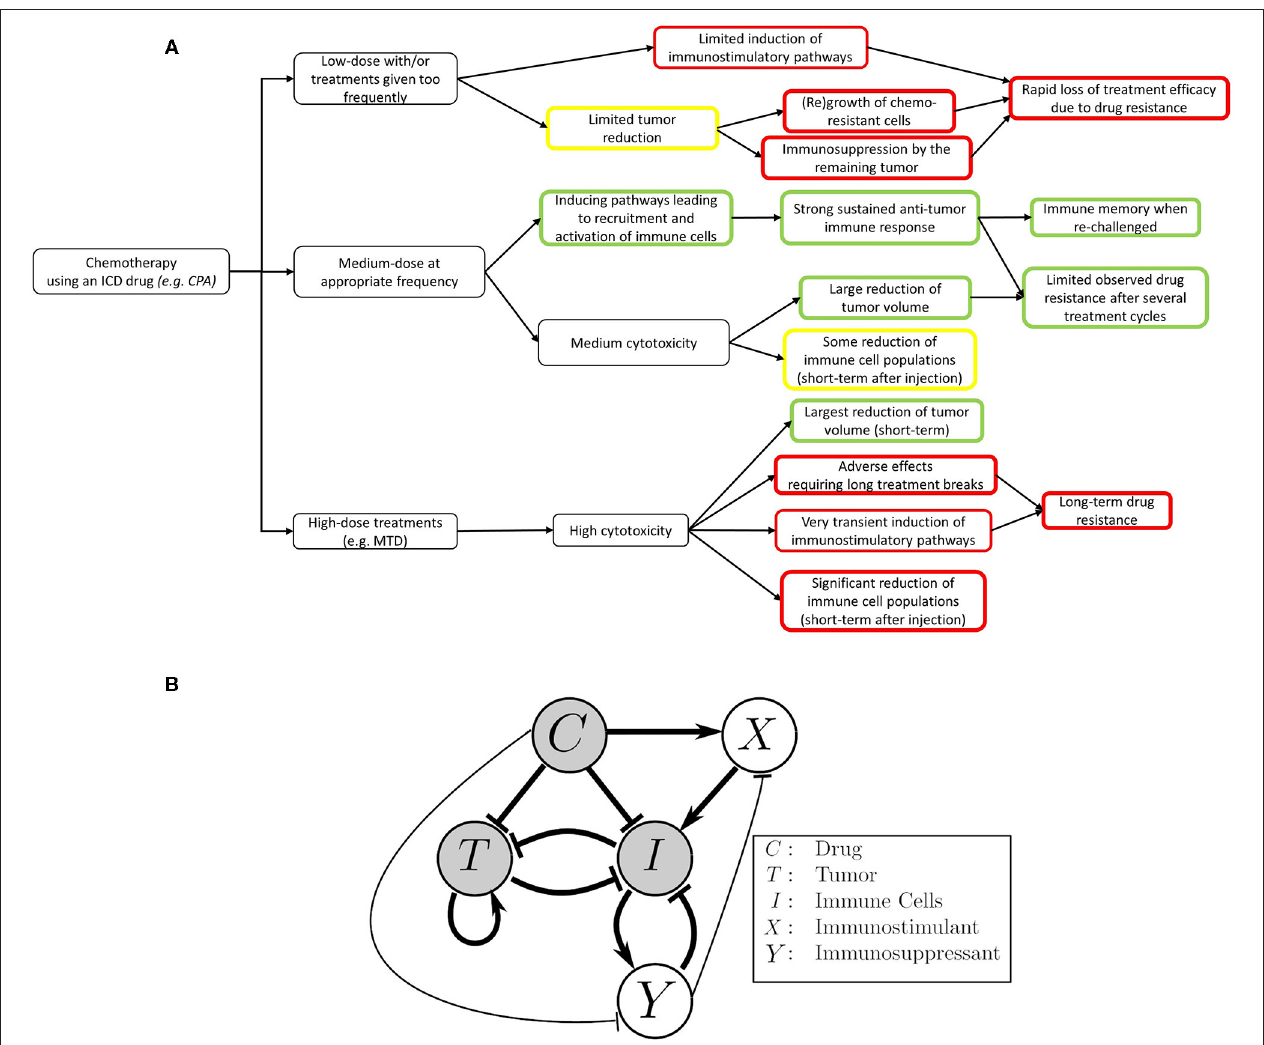
FIGURE 1 | Mobilizing and sustaining a strong immune response requires striking the right balance between drug dosage and length (duration) of the drug-free break between drug administrations. The classical view of chemotherapy treatments is that the chemotherapeutic drug suppresses the immune system and is toxic to the tumor cells, while the tumor and immune system repress one another. In this view, the immune system’s ability to act on cancer cells is greatly reduced by repeated cytotoxic drug administrations. The immune system can also be recruited to act on cancer cells by, for example, stimulating antigen presentation. The focal point of this work is to improve our mechanistic understanding on how application the right metronomic chemotherapy regimen can, in specific cases, stimulate a large increase in the immune response. Both the immunosuppressive and immunostimulatory effects of the drug are considered in our model, with the coexistence of these two seemingly opposite effects being an important point of emphasis. (A) An outline of the effects of different chemotherapy treatments on the immune system and tumor growth as observed in the context of an ICD drug like cyclophosphamide (17). (B) The translation of the outlined experimental observations into a detailed schematic diagram of the interactions that formed the basis of our model. Thicker arrows represent well-known effects. Thinner arrows are hypothesized to be present, and also arise from our numerical fits to the data. Notably, we simplified the system such that the interactions between tumor and immune cells leading to increased immune activity are omitted in the context of this work. The details about this assumption can be found in the Methods